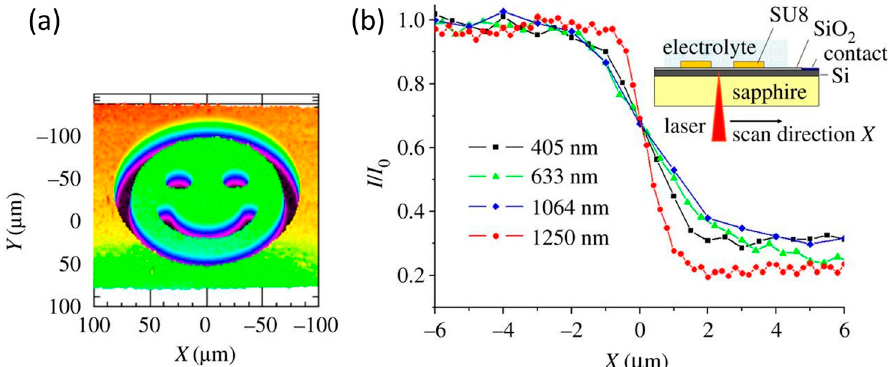
Figure 2. ( a ) Photocurrent image of the SU-8 pattern; ( b ) Normalized photocurrent curves scanning across the edge of the photoresist at different wavelengths. Reprinted (adapted) with permission from Chen et al. [45] Copyright (2019) Elsevier.